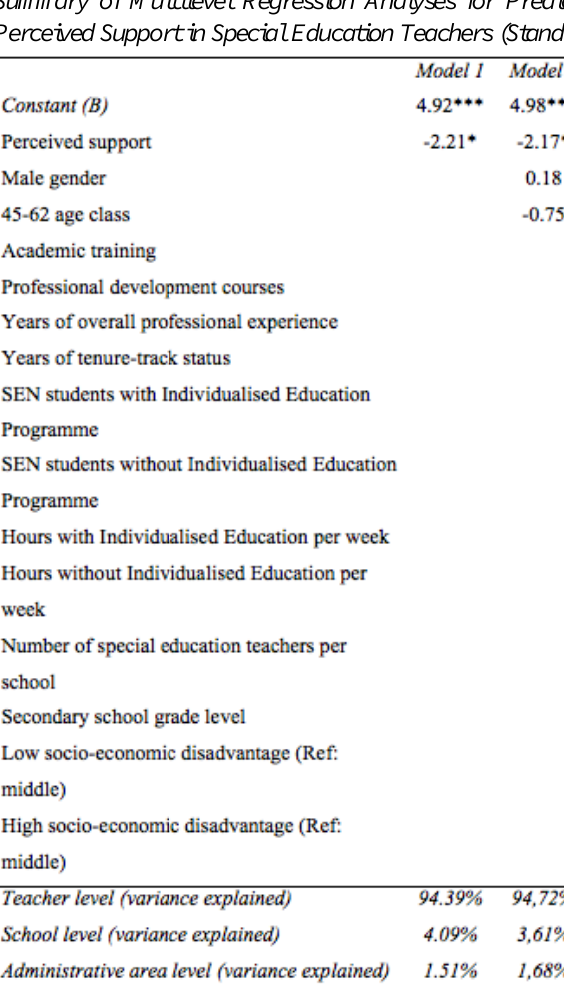
Summary of Multilevel Regression Analyses for Predicting Depersonalization